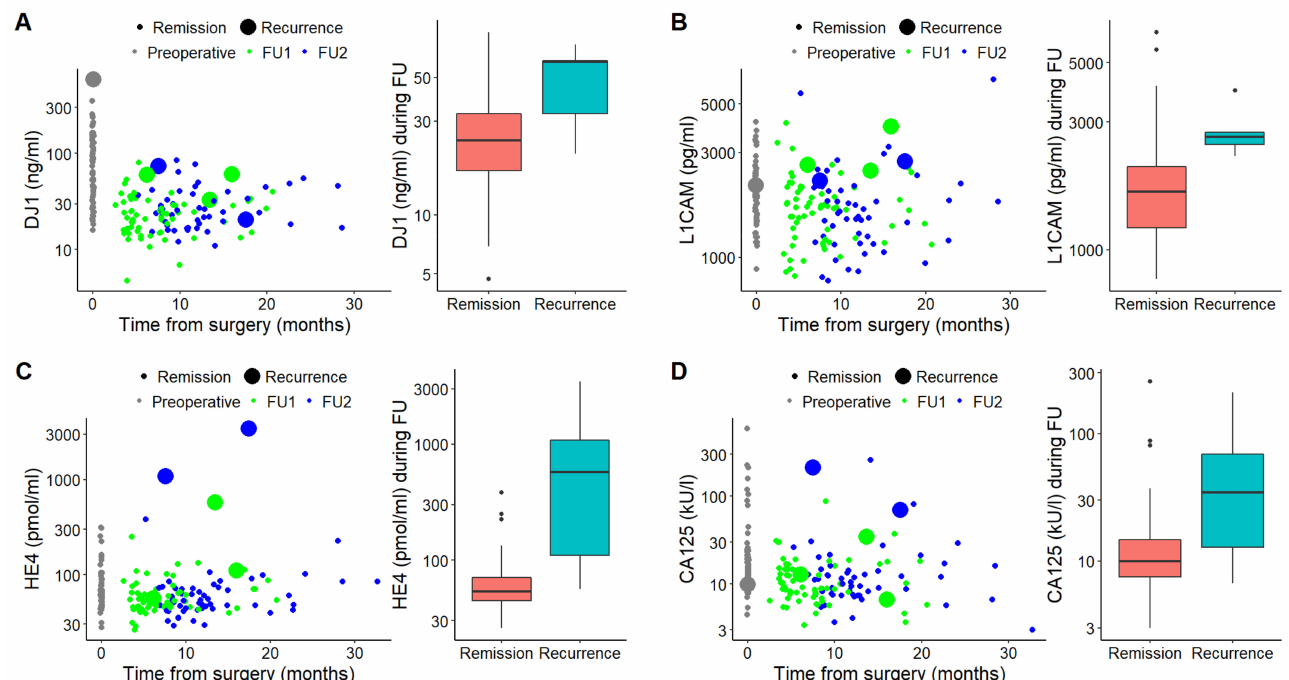
Figure 2. Charts displaying comparison of DJ-1 ( A ), L1CAM ( B ), HE4 ( C ) and CA125 ( D ) levels at the times of remission and recurrence. Scatter charts (left) display marker levels at the time of diagnosis (gray) and from the collections during follow-ups (first collection, green; second collection, blue). Large spots mean samples at the time of recurrence. Box plots (right) demonstrate marker levels at the times of remission and recurrence,